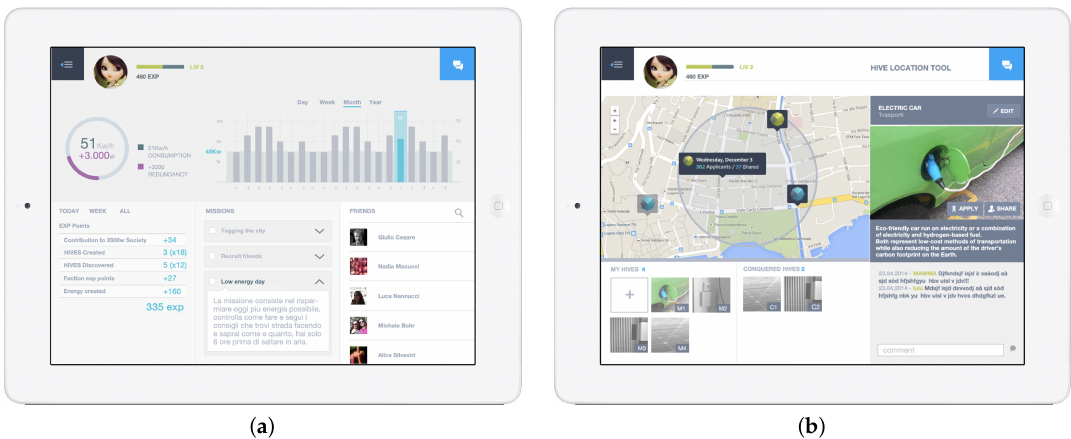
Figure 12. Examples of visualizations from the Social Power Game , showing information related to a personal profile ( a ) and a social “Energy Hive” ( b ). Image from Reference